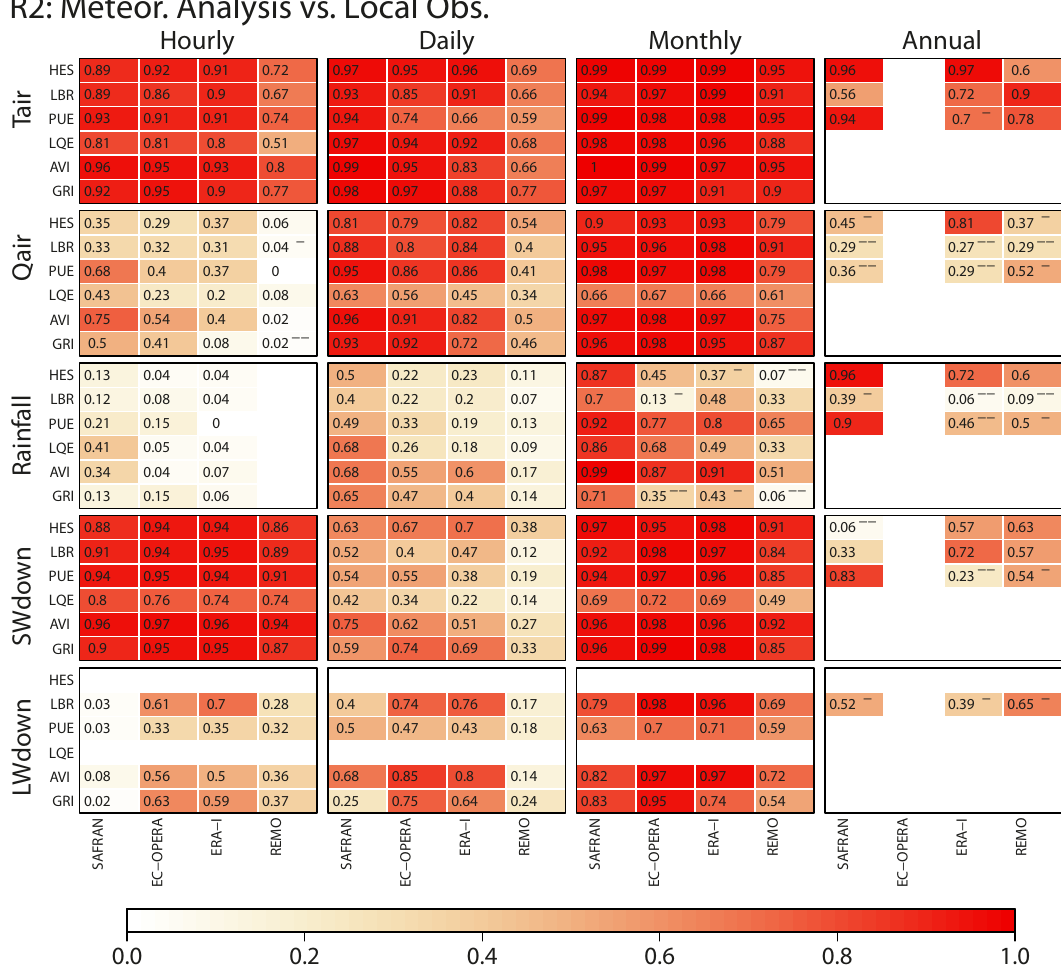
Fig. 3. Squared correlation ( R 2 ) between meteorological gridded data and in situ data over 2004 to 2007, except for EC-OPERA which covers 2004–2006. Panels of R 2 from left to right are for hourly, daily, monthly and annual time scales, respectively. Time series used to calculate R 2 correspond to growing season (GS). See text Sect. 2.1 for the definiton of GS. The default statistical confidence level of R 2 is p < 0 . 01. Otherwise, the signal “–” at the upright indicates a confidence level of p < 0 . 05 and “– –” for p > 0 . 05.